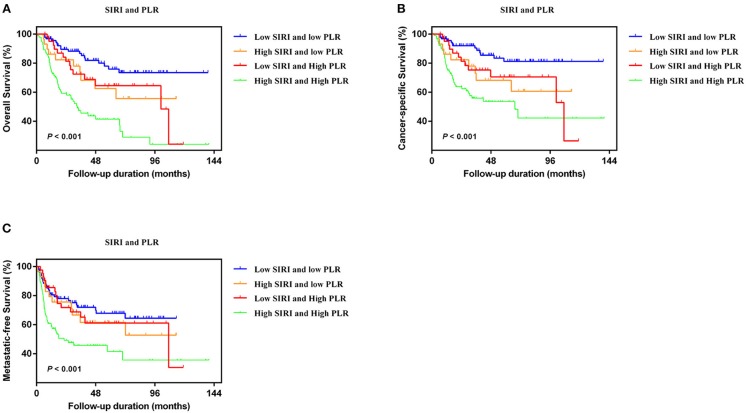
Kaplan-Meier analysis for OS (A), CSS (B), and MFS (C) in patients with UTUC who was divided into four groups based on SIRI-PLR in the training cohort.